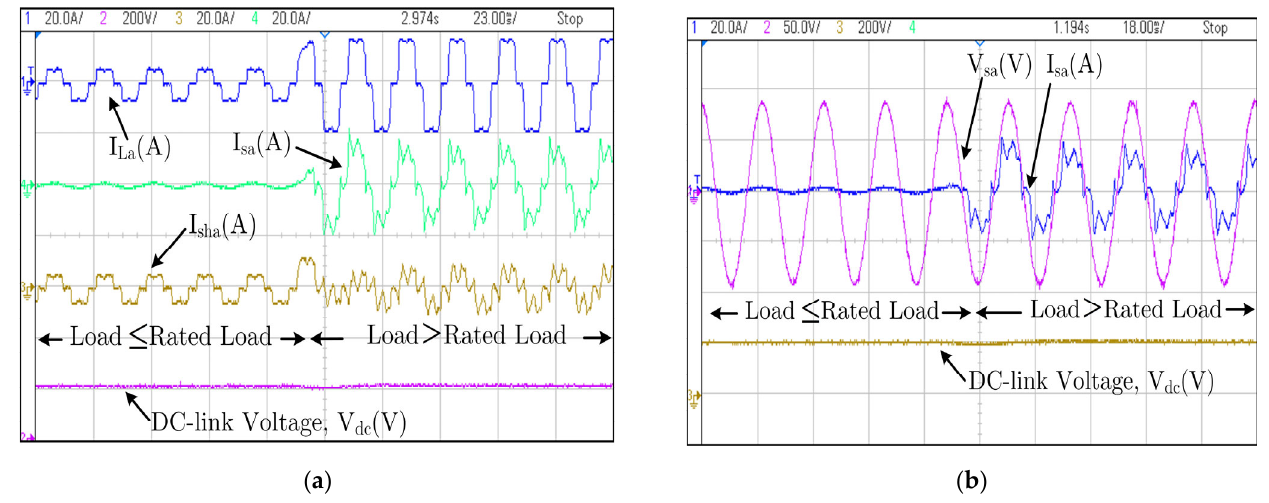
Figure 13. Under load change condition from 1000 W, 200 VAR to 2400 W, 510 VAR ( a ) load current, grid current, compensating current of phase “a” and DC ‐ link voltage; ( b ) phase relation between voltage and current and DC ‐ link voltage.